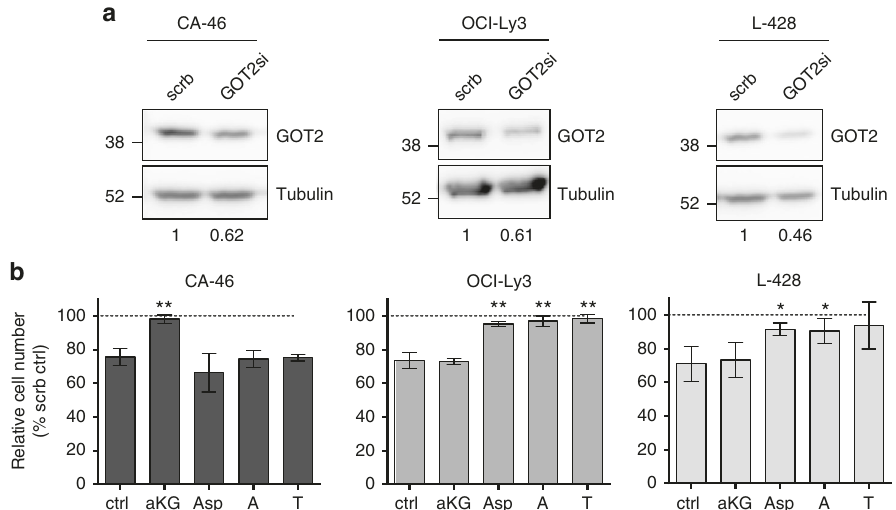
Fig. 5 Context dependent role of GOT2 in lymphoma cells. a Immunoblot of GOT2 in CA-46, OCI-Ly3, and L-428 lymphoma cells 24 h after siRNA- mediated knockdown. Knockdown ef fi ciencies (GOT2/tubulin) relative to scrb control are presented under the images. b Relative cell numbers of CA-46, OCI-LY3, and L-428 cells after GOT2 knockdown and metabolite treatment. Metabolites were used as described in Fig. 2. Error bars represent mean ± SD of three independent experiments and results from Bonferroni post hoc tests on a one-way ANOVA are given (* p < 0.05, ** p < 0.01, *** p <